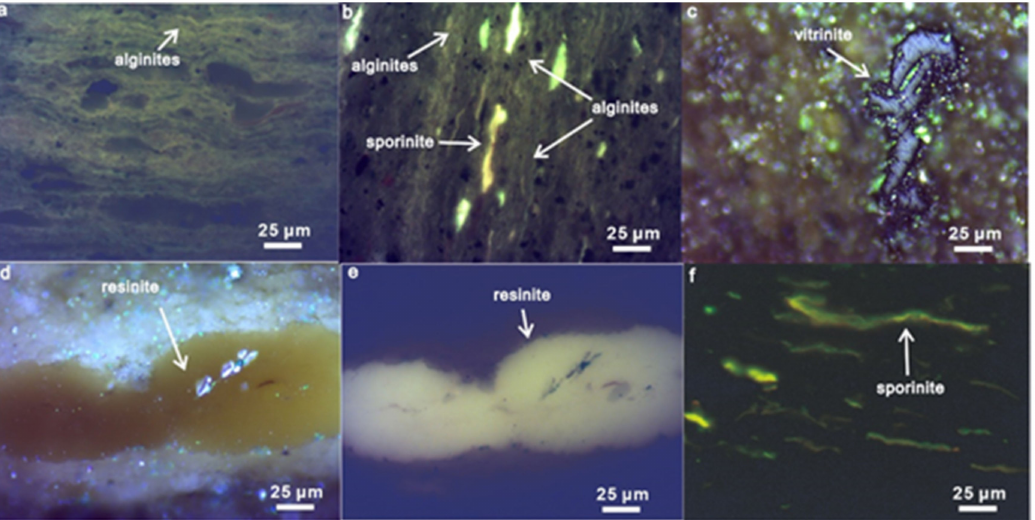
Figure 4. Characteristics of organic macerals in different quality oil shales. ( a ) 342.48 m, high-quality